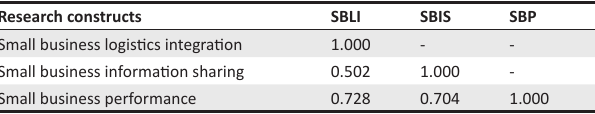
TABLE 3: Correlations between